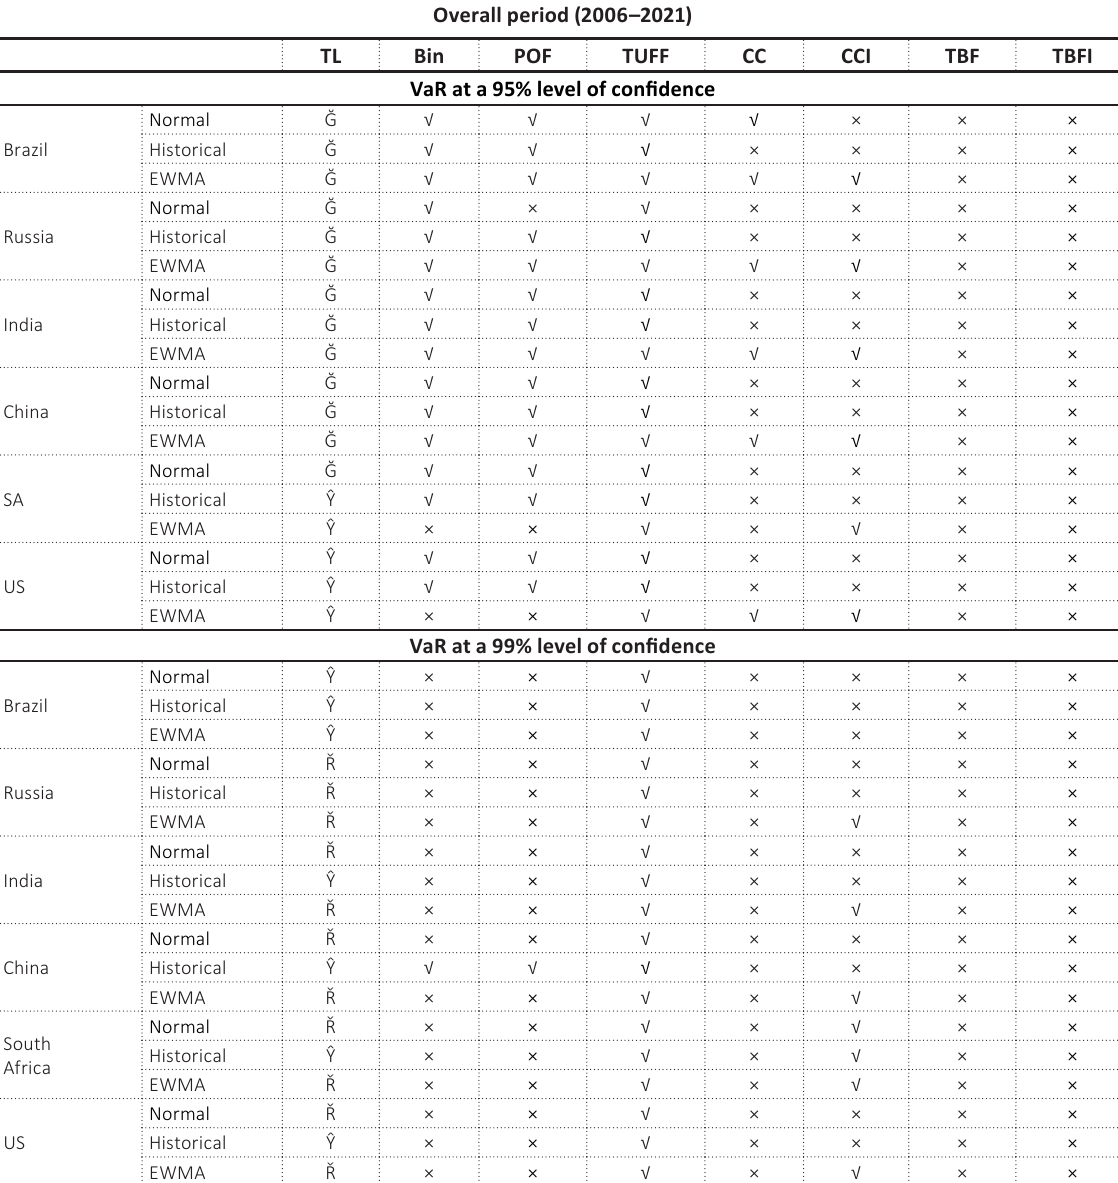
Table 2. VaR model evaluation through different backtesting methods for 2006–2021 Overall period